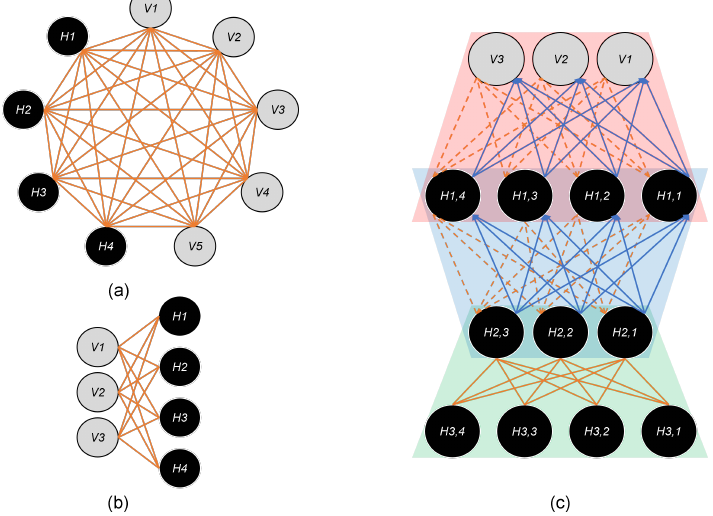
Figure 6. Boltzmann machine (BM) and its variants, where black and white nodes represent hidden and visible layers, respectively. ( a ) Original BM with all undirected connections. ( b ) Restricted Boltzmann Machine (RBM) with fewer connections. ( c ) Three 2-layer RBMs (Red, Blue, Green) combine to form a Deep belief Network (DBN), with the top 2 layers having directed connections (blue). However, when all connections are undirected (orange), a Deep Boltzmann machine (DBM) is